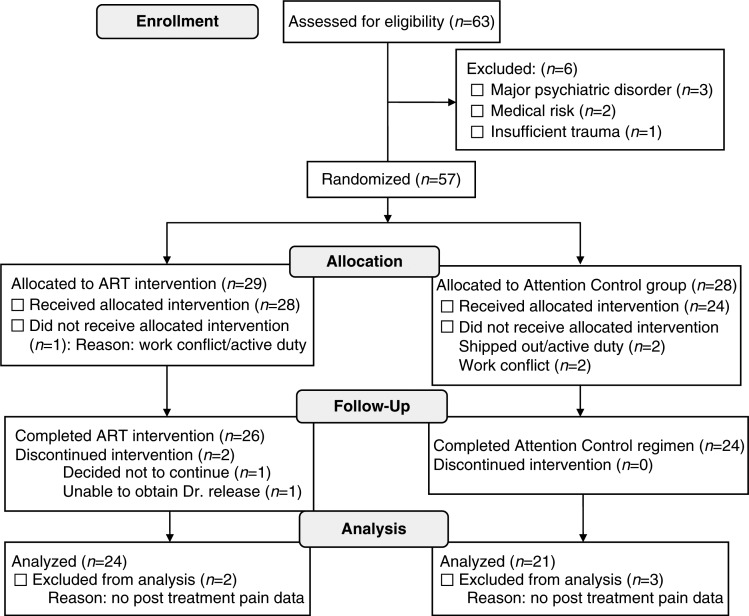
Consort diagram of the trial population including those screened, enrolled, randomly assigned, completing treatment, and analyzed.